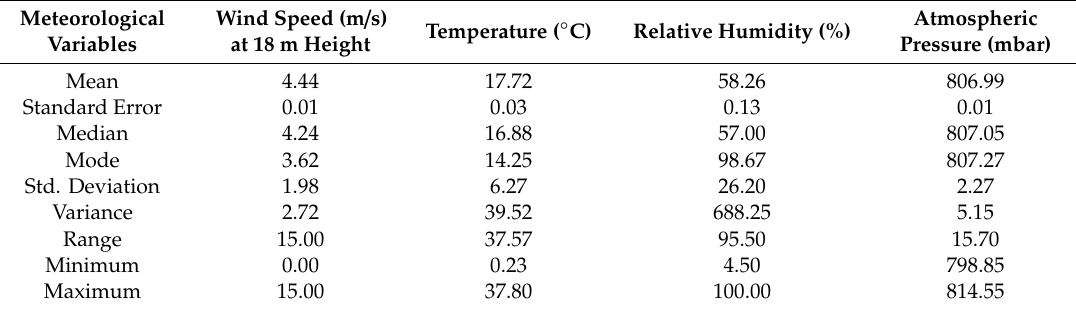
Table 2. Statistical analysis of meteorological variables.